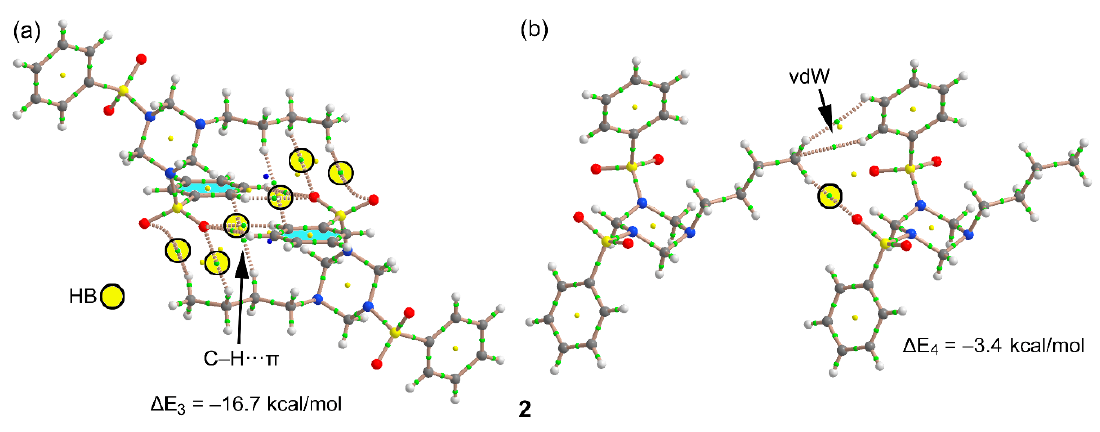
Figure 12. ( a , b ) Distribution of bond, ring and cage critical points (green, yellow and blue spheres, respectively) and bond paths in two dimers of complex 4 . The C–H···O bonds are highlighted. 4. Concluding Remarks In summary, the synthesis and single crystal X-ray diffraction characterization of four N-substituted 1,3,5-triazinanes are reported along with a detailed analysis of the noncovalent interactions observed in the solid state. All complexes have in common the formation of several motifs characterized by a network of C–H···O interactions that exhibits very strong binding energies as a consequence of these cooperative H-bonds. Moreover, several structures also form interesting C– H···π ···H–C ternary assemblies that have been described in detail. Besides, the MEP surfaces have been used to rationalize the noncovalent interactions and the QTAIM method to confirm the existence of the intricate combinations of H-bonds. Finally, the Hirshfeld surface analysis provides further evidence for the importance of C– H···π and C –H···O in the crystal packing of compounds 1 –